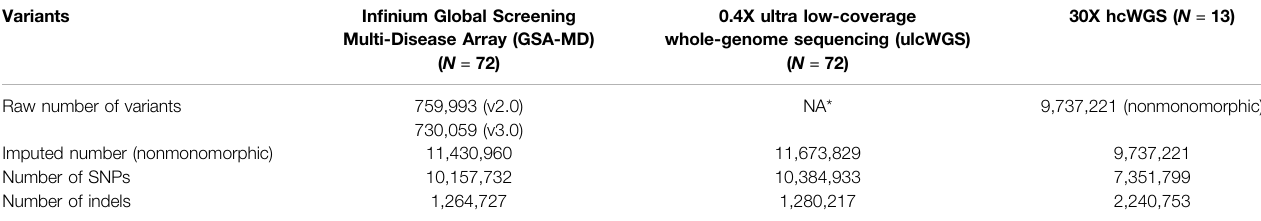
TABLE 1 | Non-monomorphic variants captured by different platforms in this study.